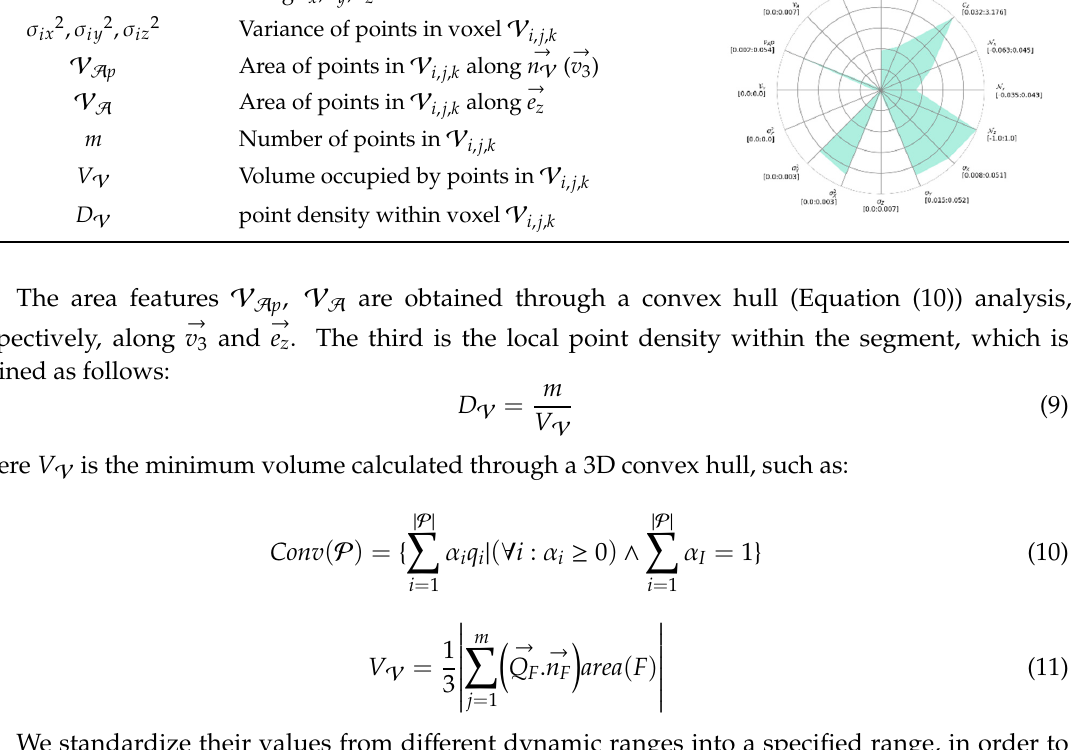
Figure 6: Box plot of primary elements feature